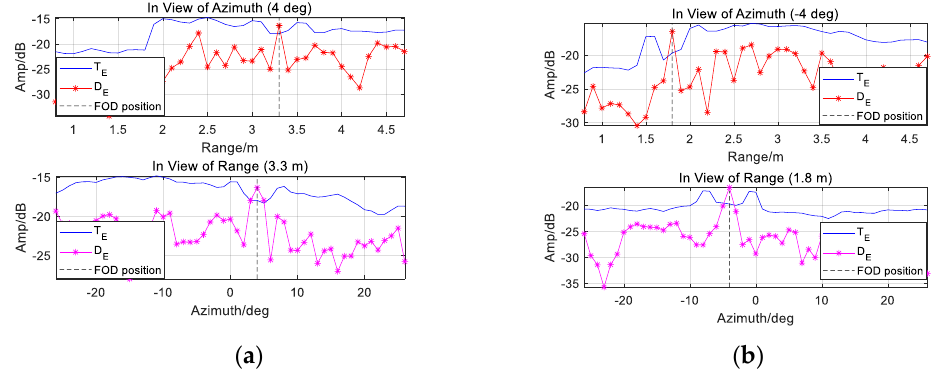
Figure 10. The results of CA-CM-CFAR processor are shown in view of range and azimuth, aiming